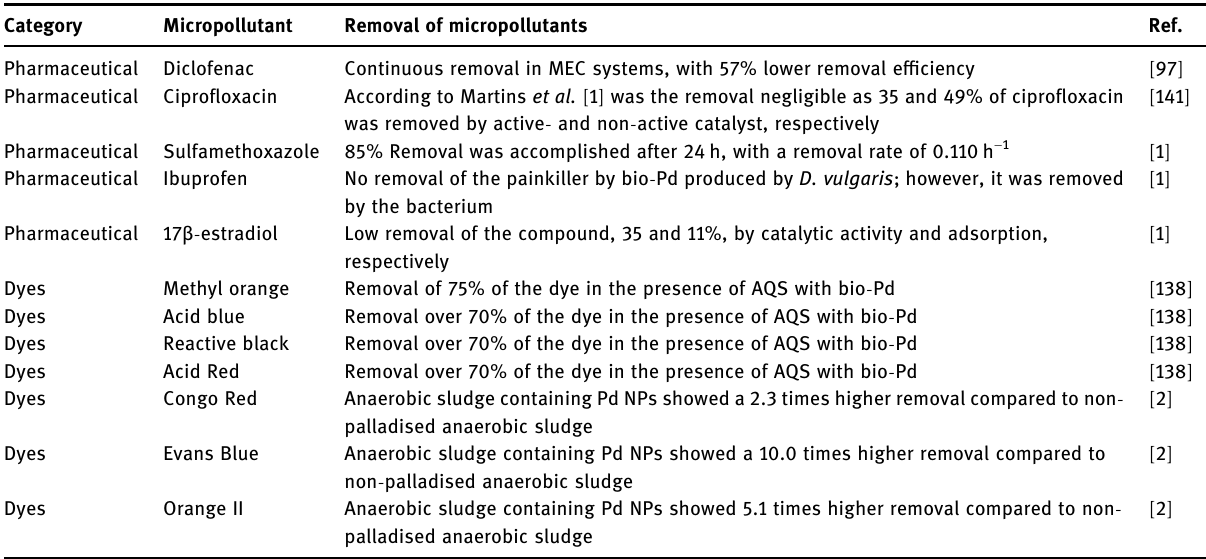
Table 3: Overview of the micropollutants removed by bio - Pd